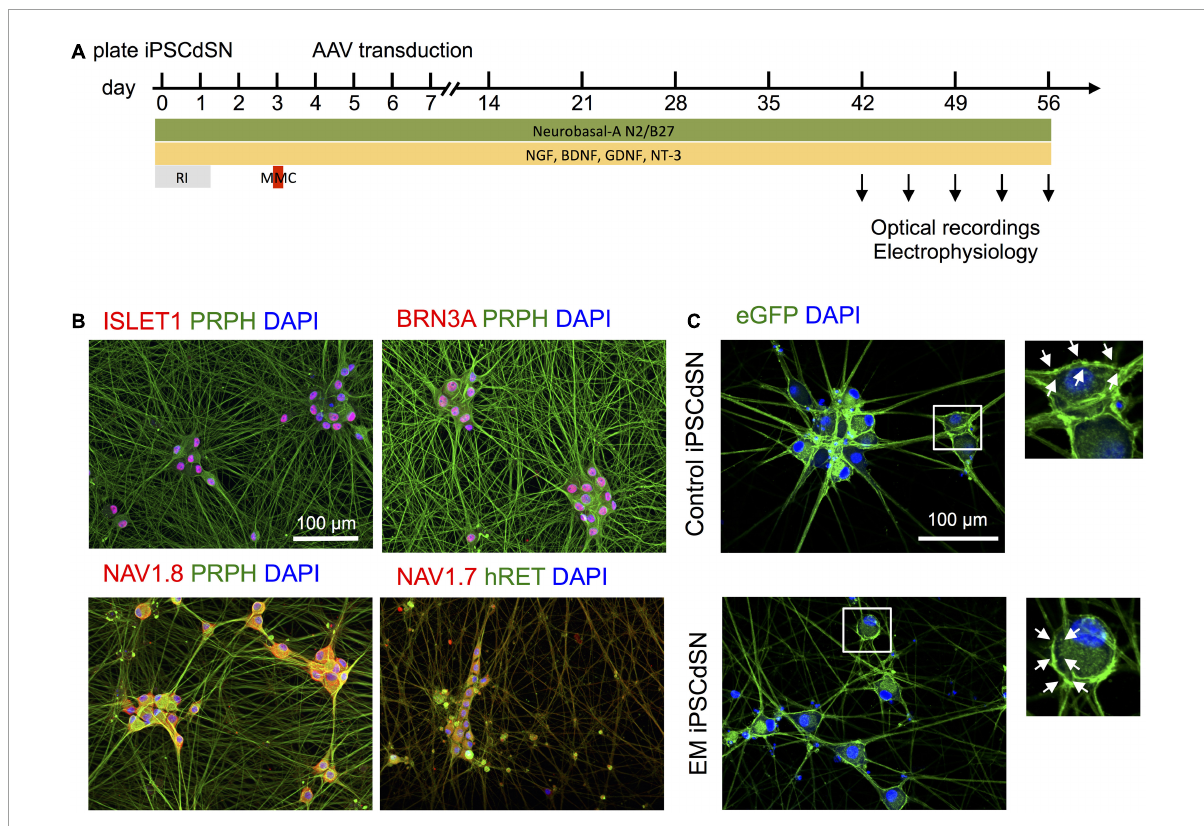
FIGURE1 (A) In vitro cultivation and adeno-associated viruse (AAV) transduction paradigm for human induced pluripotent stem cell (hiPSC)-derived sensory neurons. RI, ROCK-Inhibitor, MMC: Mitomycin C. (B) Human induced pluripotent stem cell-derived sensory neuron (hiPSCdSN) express typical sensory neural marker, such as ISLET1, BRN3A, and PRPH, as well as peripheral sodium channels Nav1.7 and Nav1.8. (C) Dark quencher hybrid genetically encoded voltage indicator (dqGEVI) specifically labels the sensory neuronal cell membrane. EM,